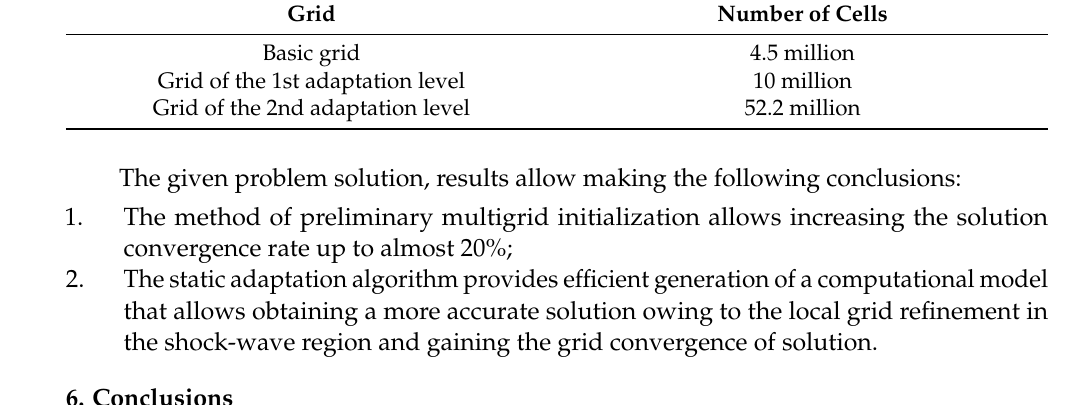
Table 4. Characteristics of computational grids (LM1021).